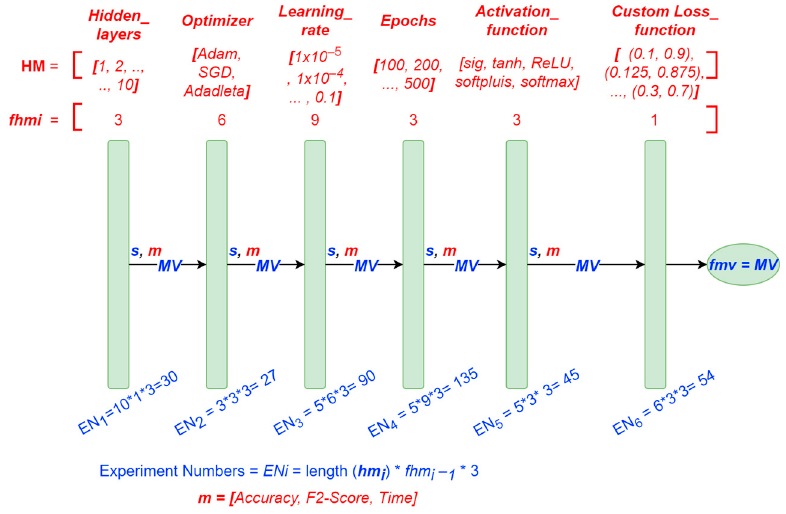
Figure 7. Graph procedure of the proposed tuning methodology and the values used.